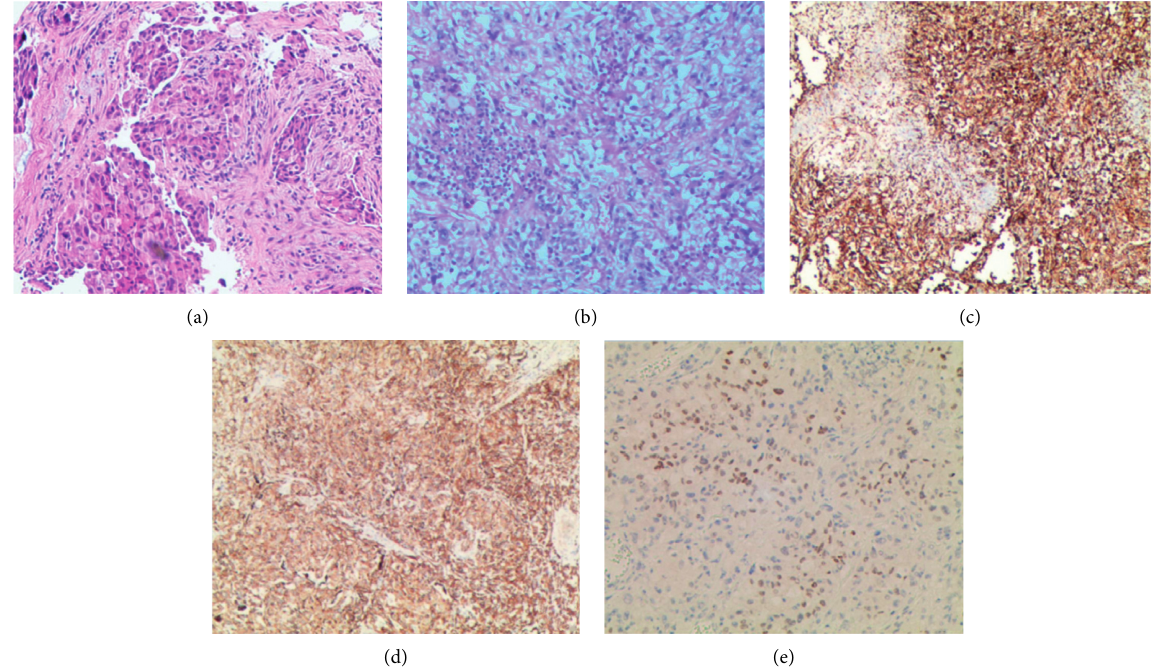
Figure 1: Pathological image of the patient diagnosed with lung adenocarcinoma in case 1 ((a) hematoxylin and eosin × 100). Pathological image of the patient diagnosed with PSC in case 1 ((b) pleomorphic carcinoma; hematoxylin and eosin × 100). Immunohistochemical images of the patient diagnosed with PSC in case 1 ((c) vimentin (+); (d) CK (+); (e) TTF-1 (+) taken using the Roche Ventana BenchMark XT autostainer ( × 100) (Roche Holding, Basel,